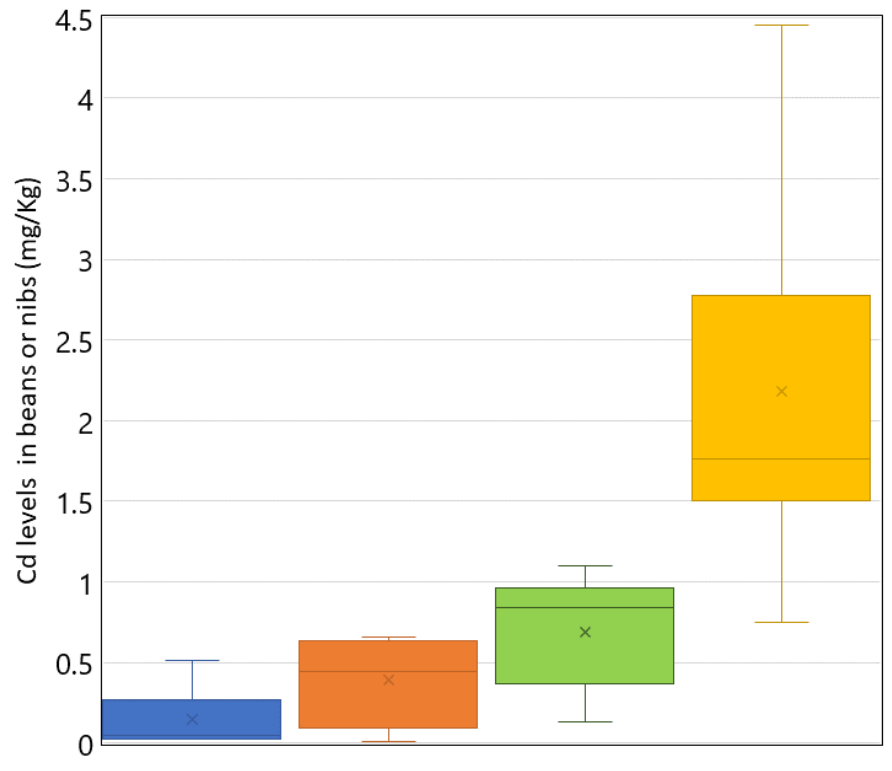
Figure 1. Cadmium levels in cacao beans and nibs from Africa, Asia, Latin America and the Caribbean (LAC) and San Vicente de Chucurí (SVC) (data from [10,14]). Overlaid: the ideal maximum level of 0.5 mg/kg (IML, dashed grey line); the acceptable limit in beans of 0.8 mg/kg (ALB, dashed black line); and the maximum proposed limit of 1.3 mg/kg Cd for cocoa powder (100% total cocoa solids on a dry matter basis) set by the Codex Committee on Contaminants in Food (MPL, dashed red line) [14,28].